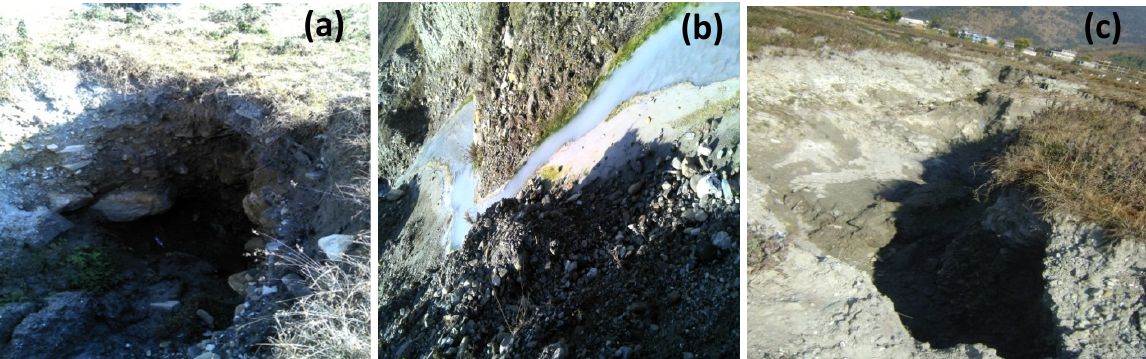
Figure 7. ( a ) Google image of 2004, Armala and ( b ) Google Image of 2014, Armala.